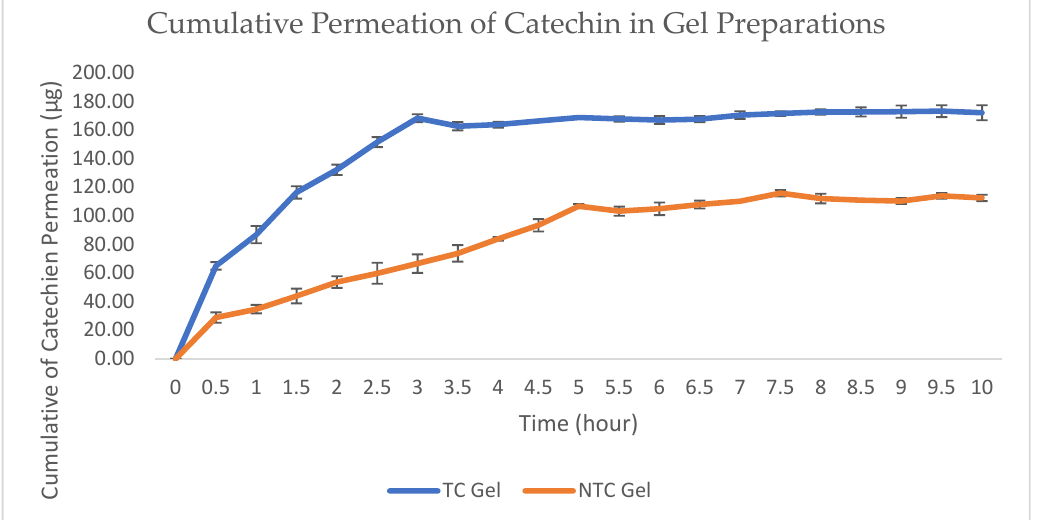
Figure 9. Cumulative permeation of transethosomal catechin gel and non-transethosomal catechin gel. Furthermore, the cumulative amount of drug penetrated is plotted at each sampling time. The regression equation obtained from this cumulative amount shows the total flux of the penetrated drug.